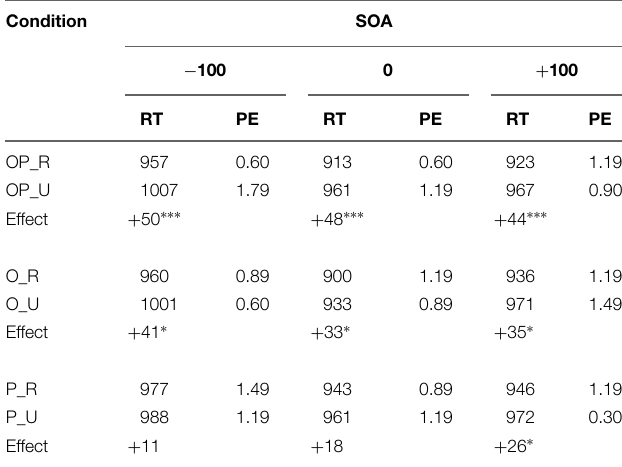
TABLE 1 | Mean response latencies (RT in milliseconds) and mean error percentages (PE) in Experiment 1. Condition SOA